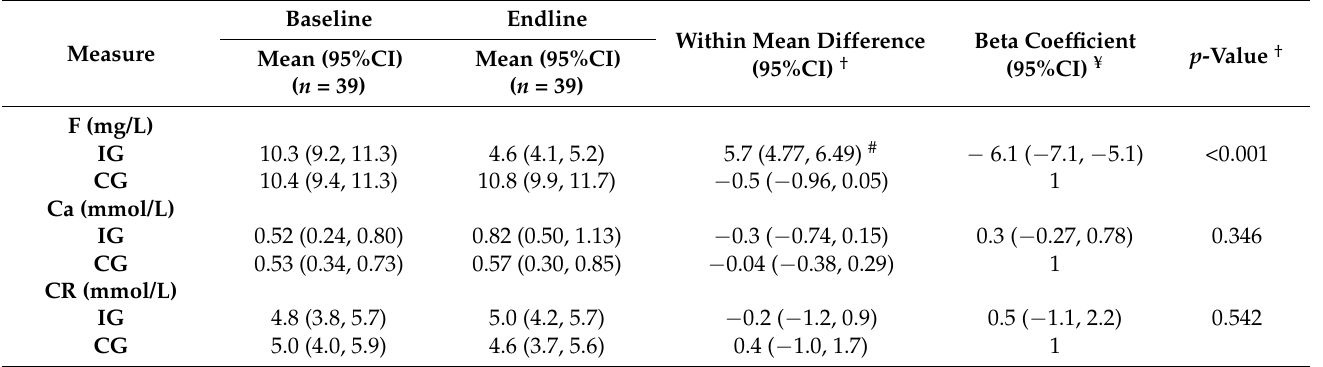
Table 3. Urinary excretion of fluoride (F), calcium (Ca), and creatinine (Cr) of women in the intervention and control groups in Halaba district, Ethiopian Rift Valley, 2018.